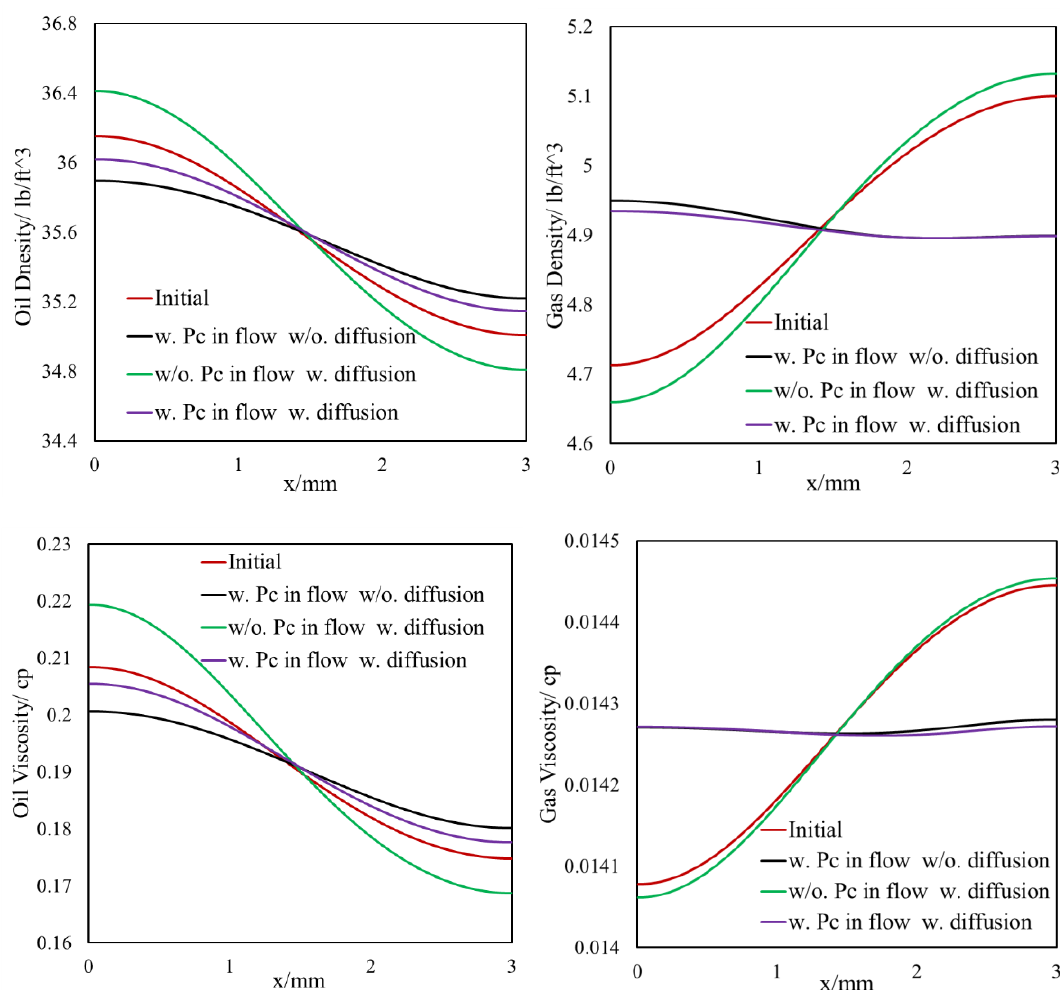
Figure 15. Oil and gas density/viscosity profile, with Pc in flow without diffusion vs. without Pc in flow with diffusion vs. with Pc in flow without diffusion, 100 days, ternary mixture.